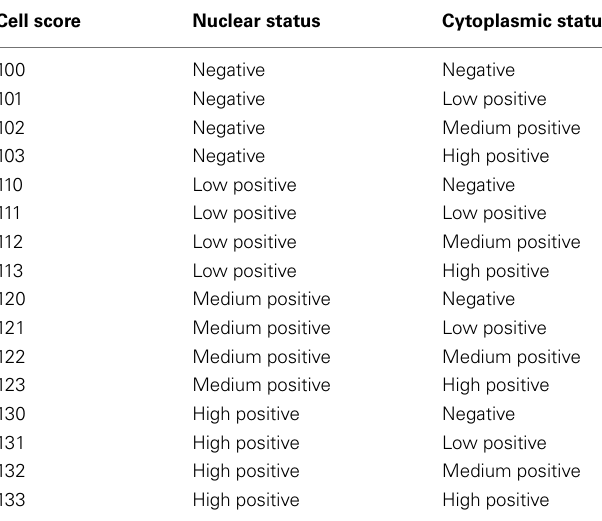
Figure 3 . Results were compiled using Microsoft Excel (version 2010).